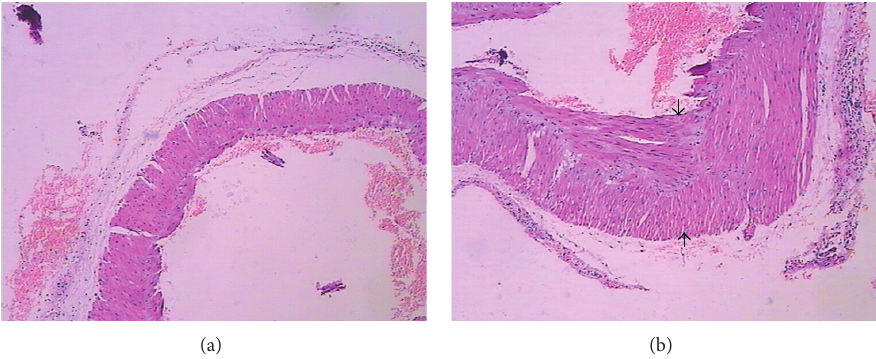
Figure 6: Hematoxylin and eosin staining of the portal vein. (a) Control group and (b) week 10 after CCl4 injection.